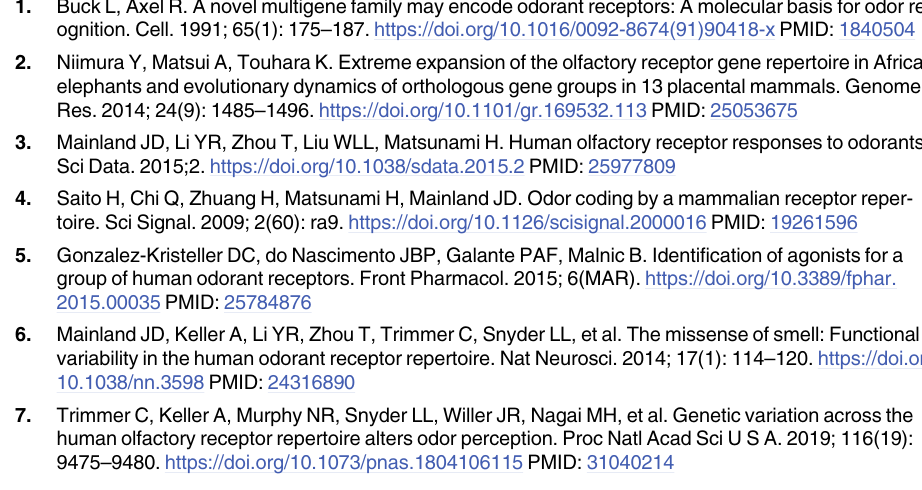
S1 Table. OR sequences used in this study. S2 Table. OR screening using HEK293 cells against six odorants (Fig 1). S3 Table. OR screening using four cell lines against an odorant mixture (Fig 2). S4 Table. Background basal activity of 412 ORs expressed in HEK293 cells (related to Fig 5E). S5 Table. Comparison with genetic variants used in previous